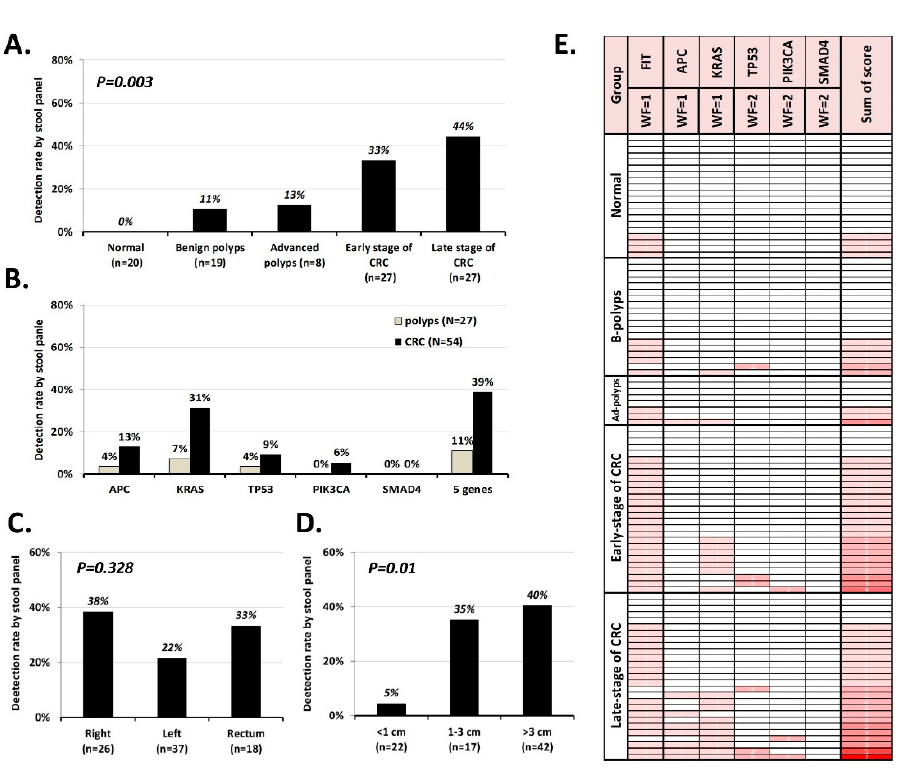
Figure 4. Clinical validation of the sDNA test in cohort 2. ( A – D ). Detection rate versus various clinicopathological factors and gene mutations. ( E ). A risk-stratified scoring system was constructed by integrating the FIT value (FIT ≥ 500 ng/mL, weighting factor = 1), the presence of mutations in APC , KRAS (weighting factor = 1 for either), TP53 , PIK3CA , and SMAD4 (weighting factor = 2 for each). The gradient color represents the score.